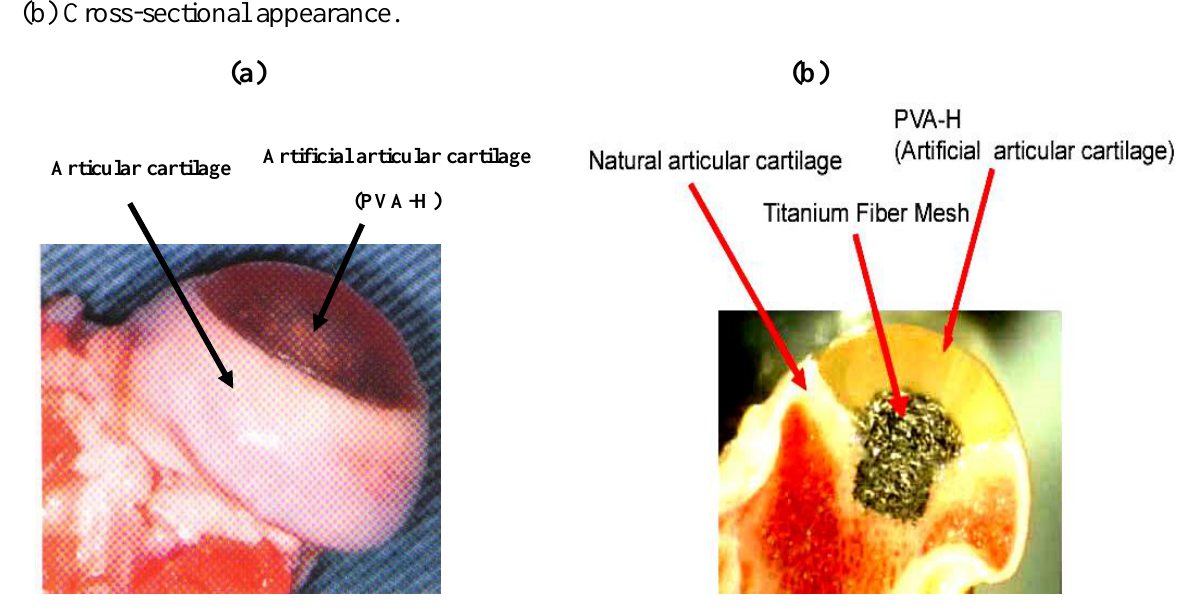
Figure 13. Photograph of a specimen of the canine femoral head with composite osteochondral device at 12 months after implant operation. (a) Macroscopic appearance.